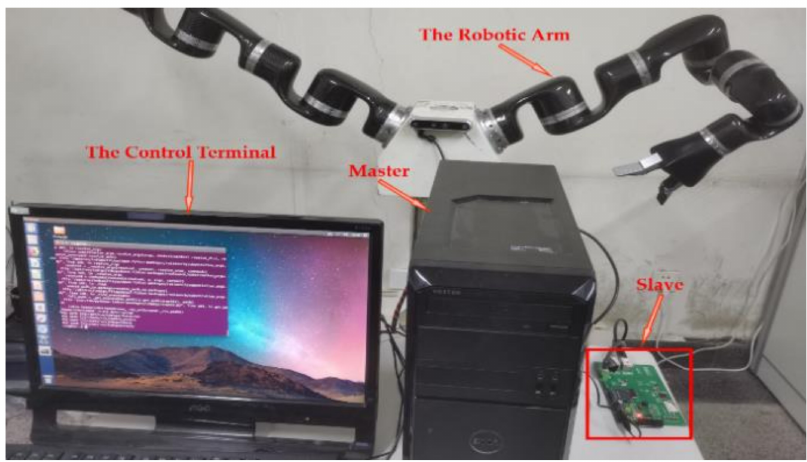
Figure 5. Physics experiment